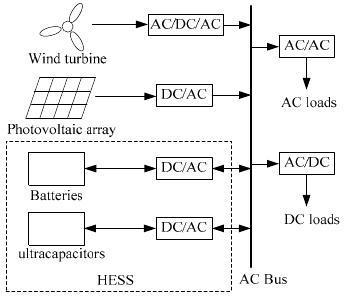
Figure 1. Schematic diagram of an isolated microgrid.